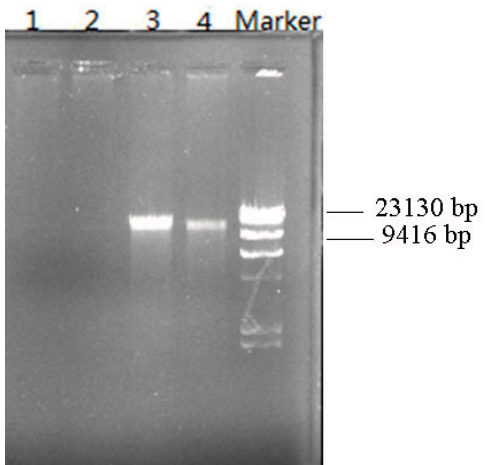
Figure 6. Plasmid DNA electrophoresis before and after the plasmid-elimination test. 1–2: Plasmid DNA after plasmid elimination; 3–4: Plasmid DNA before